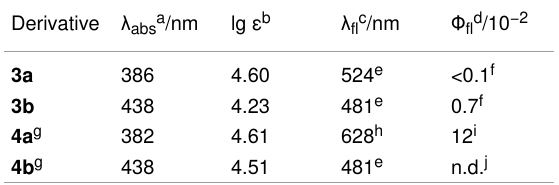
Table 1: Absorption and emission properties of the derivatives 3a , 3b , 4a , and 4b . Derivative λ abs a /nm lg ε b